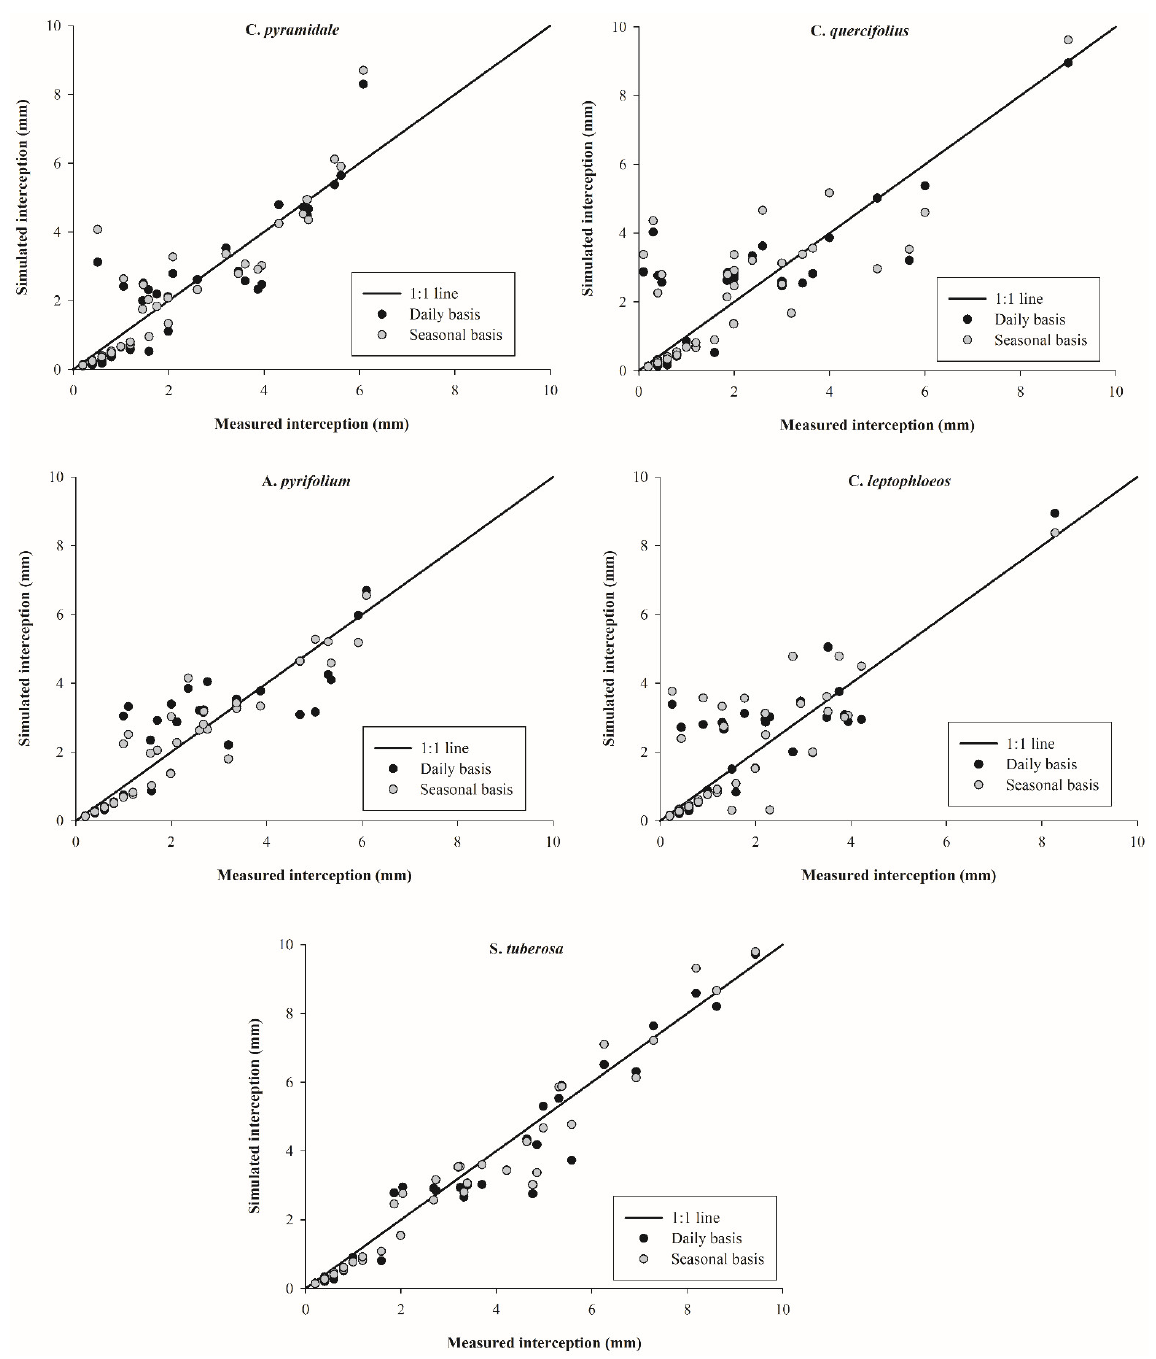
Figure 6. Validation graphs of experimental interception values against those predicted by the sparse Gash model parametrized on daily and seasonal bases applied to Caatinga species.